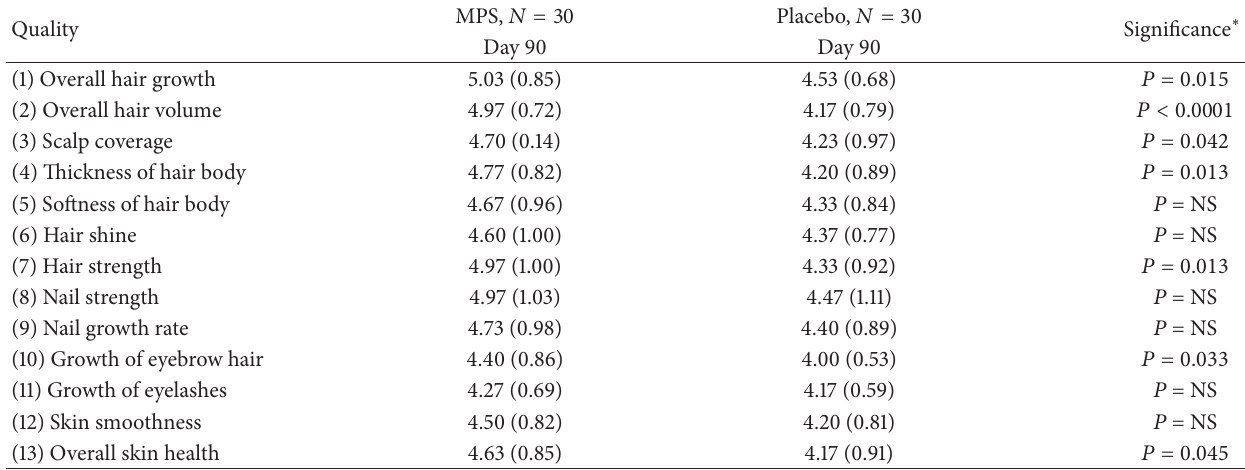
Table 2: Self-Assessment Questionnaire results.